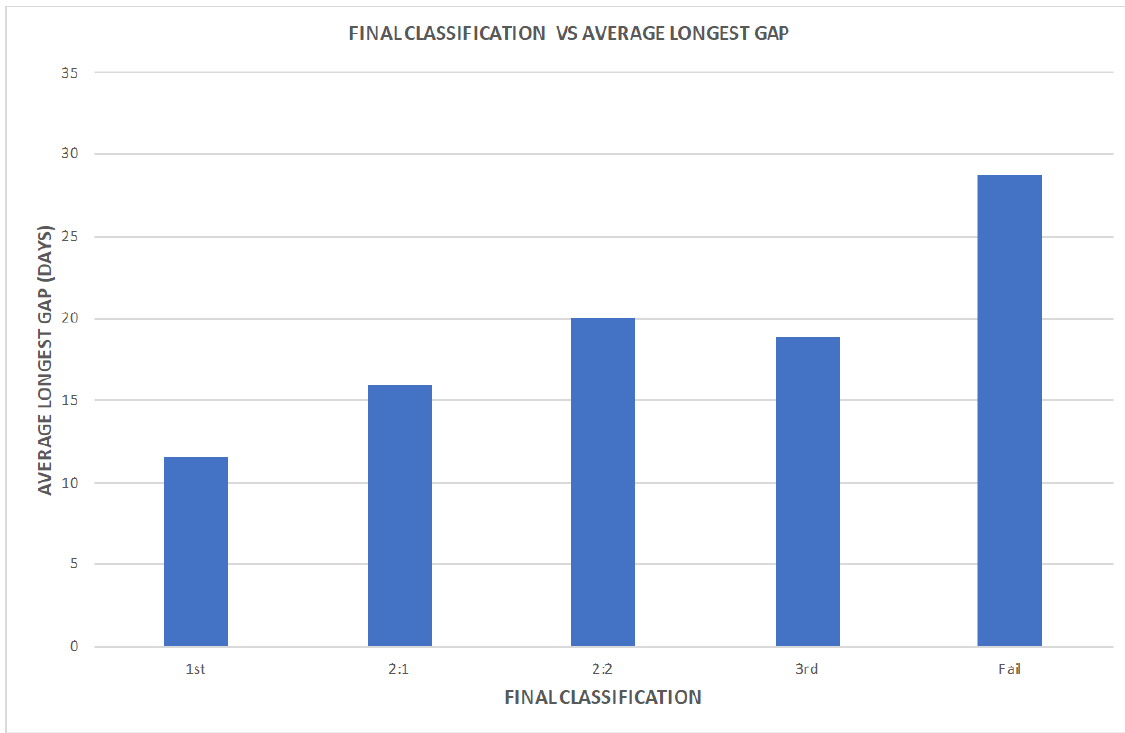
Figure 11 . Final Classification vs Average Longest gap between